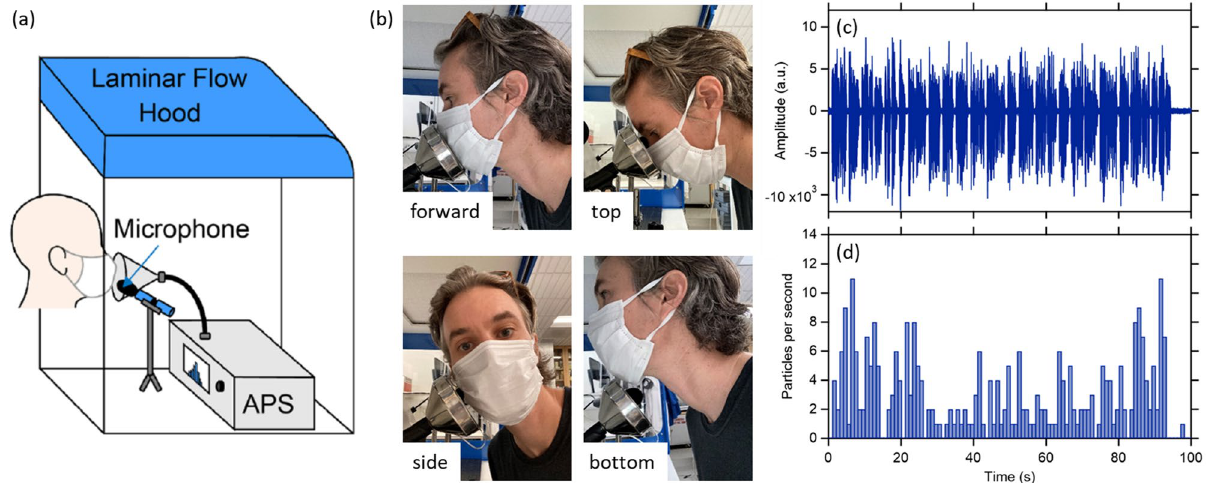
Figure 1. ( a ) Illustration of the experimental setup showing a participant wearing a surgical mask in the through-mask (forward) orientation. ( b ) Photographs of the participant position for the four different sampling orientations: forward, top, side, and bottom sampling. ( c ) Example microphone recording for participant M1 while speaking the rainbow passage with no mask, and ( d ) the associated particle counts by the